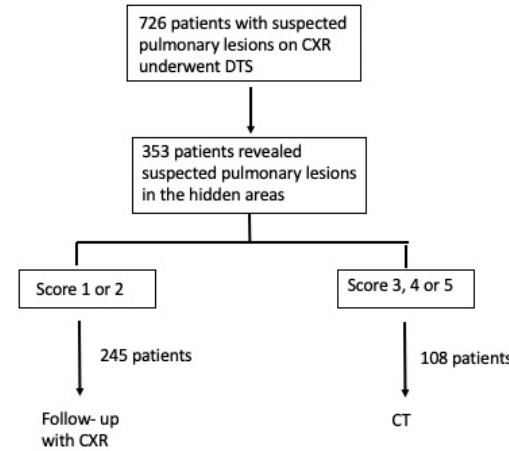
Figure 1. Flow diagram of the study population.